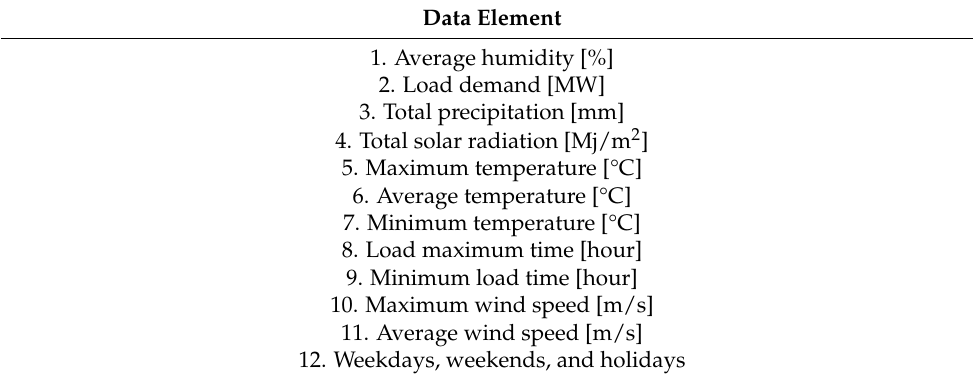
Table 1. Clustering Elements of